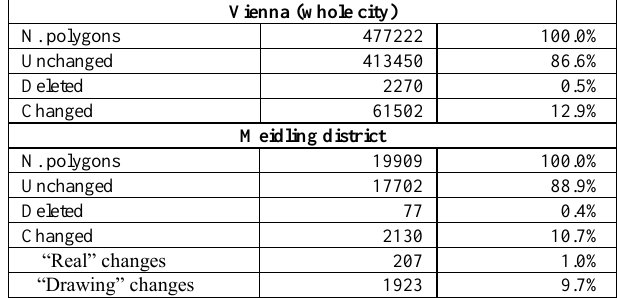
Table 1. Changes in the Footprints-2012 dataset with regards to the Footprints-2015 one, for the whole city and Meidling